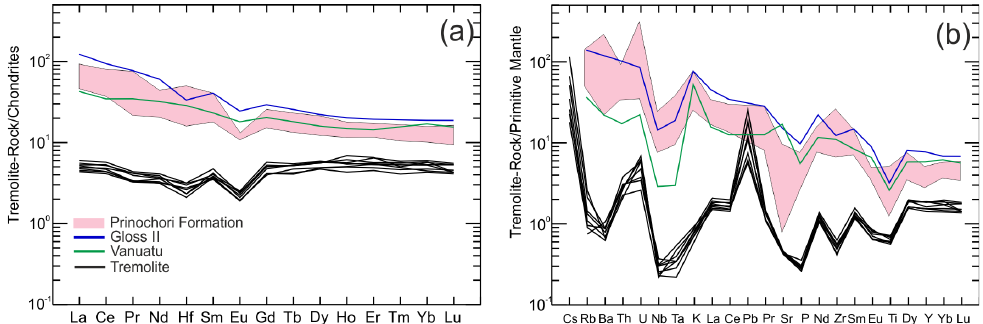
Figure 7. Tremolite ( a ) Chondrite and ( b ) multielemental Primitive Mantle normalized spider dia- grams, after [36], compared to the metasedimentary rocks of Prinochori Formation as pink field after [26] and subducted sediments from Vanuatu and Gloss II, after [37]. after [26] and subducted sediments from Vanuatu and Gloss II, after